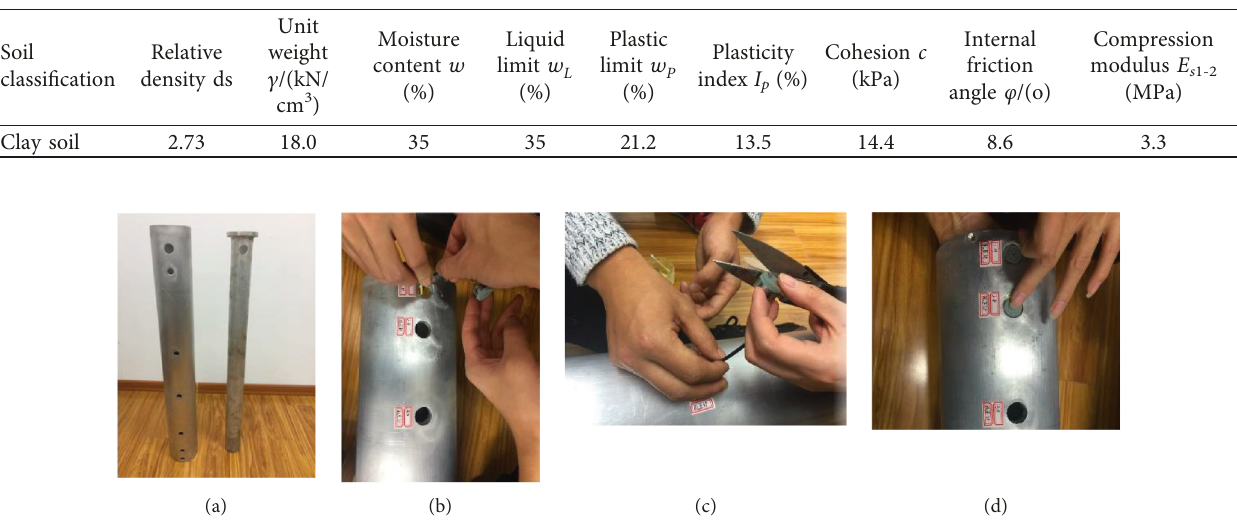
Table 1: Physical and mechanical parameters of foundation soil.